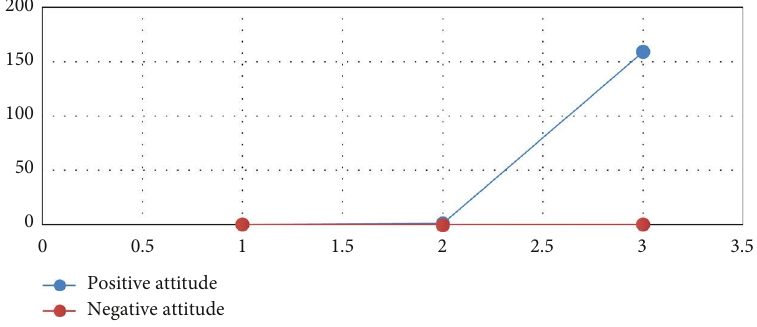
F IGURE 1: Learners ’ attitude